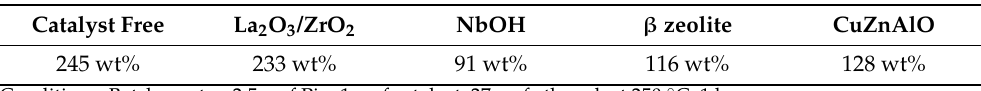
Table 2. Impact of heterogeneous catalysts’ addition on the mass balance of pine wood fractionation in SC ethanol at 250 ◦ C. Catalyst Free La 2 O 3 /ZrO 2 NbOH β zeolite CuZnAlO